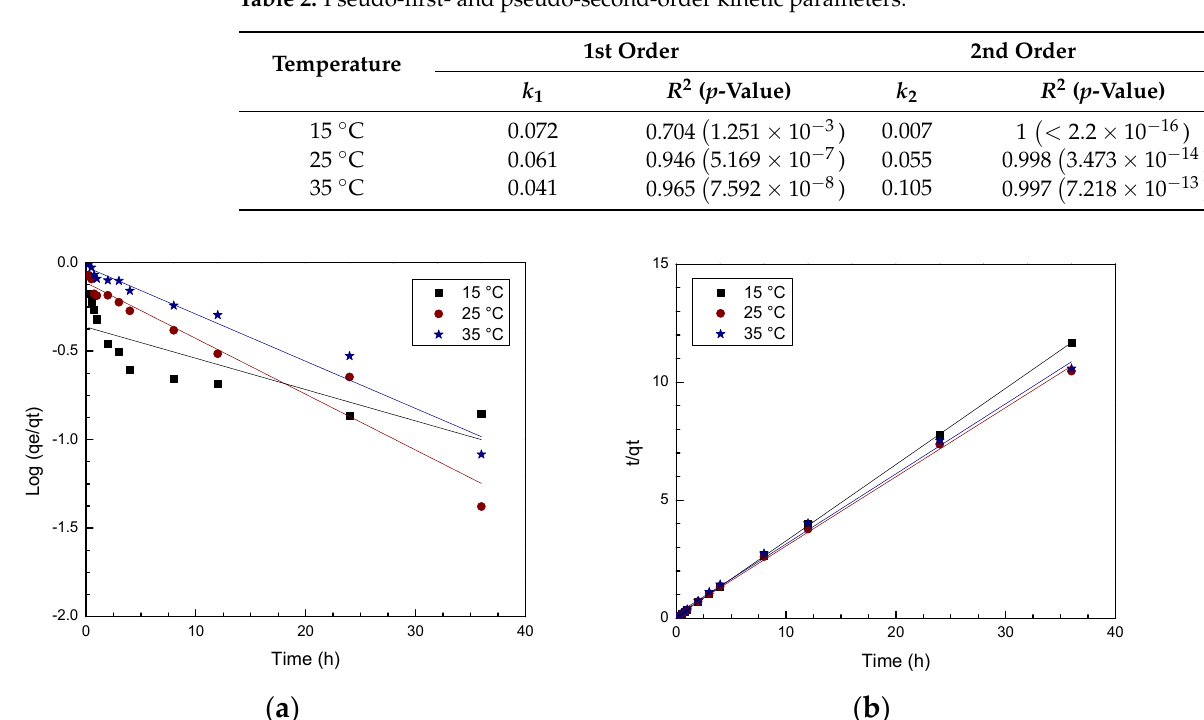
Table 2. Pseudo-first- and pseudo-second-order kinetic parameters.